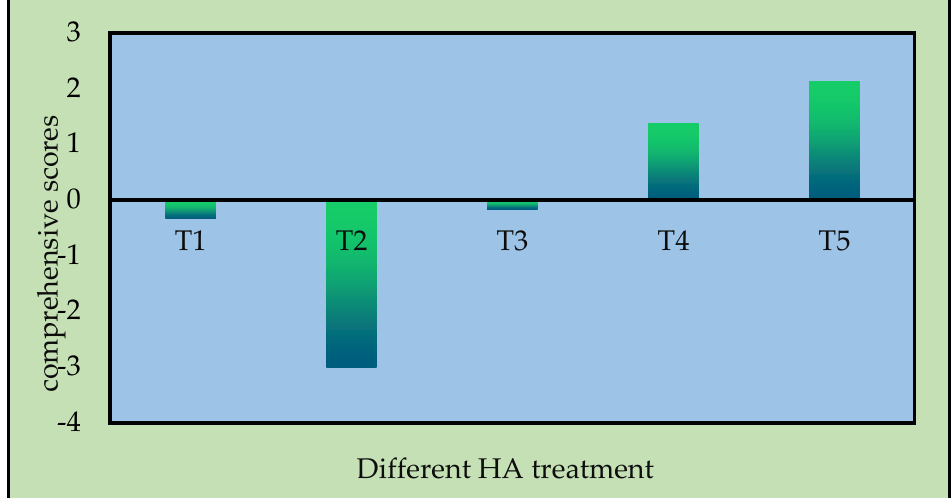
Figure 6. The comprehensive scores based on the principal component analysis.